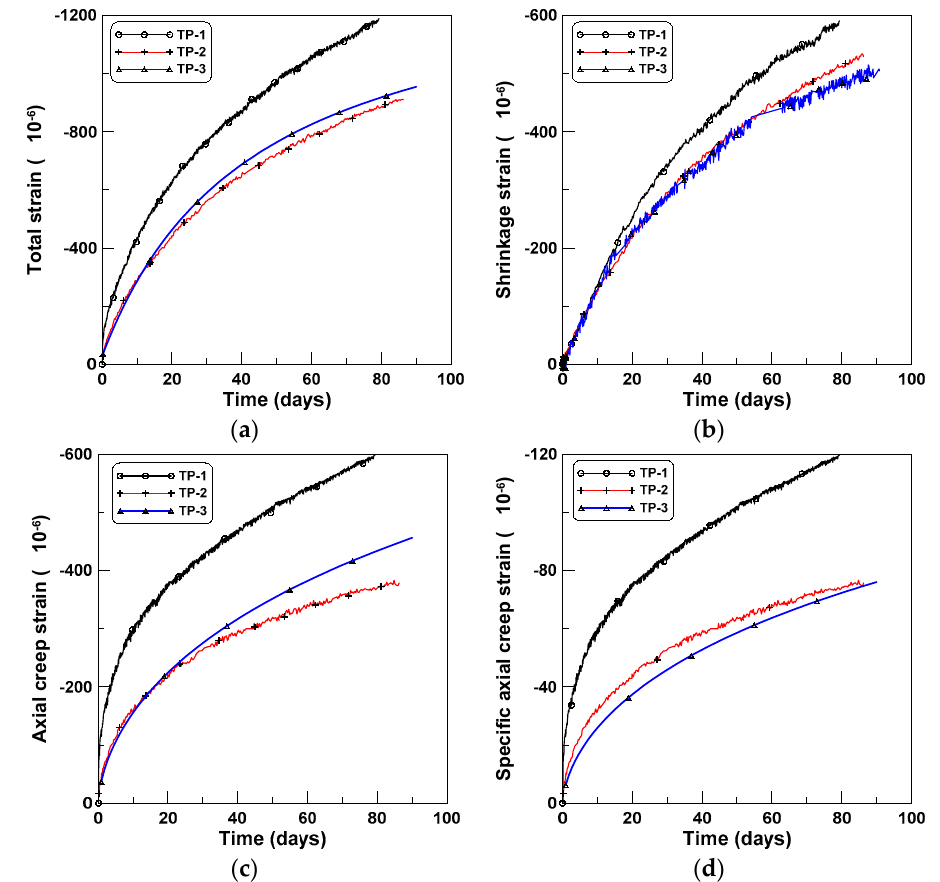
Figure 3. Compressive creep tests: ( a ) total strains, ( b ) shrinkage stains, ( c ) creep strains, and ( d ) specific creep strains.